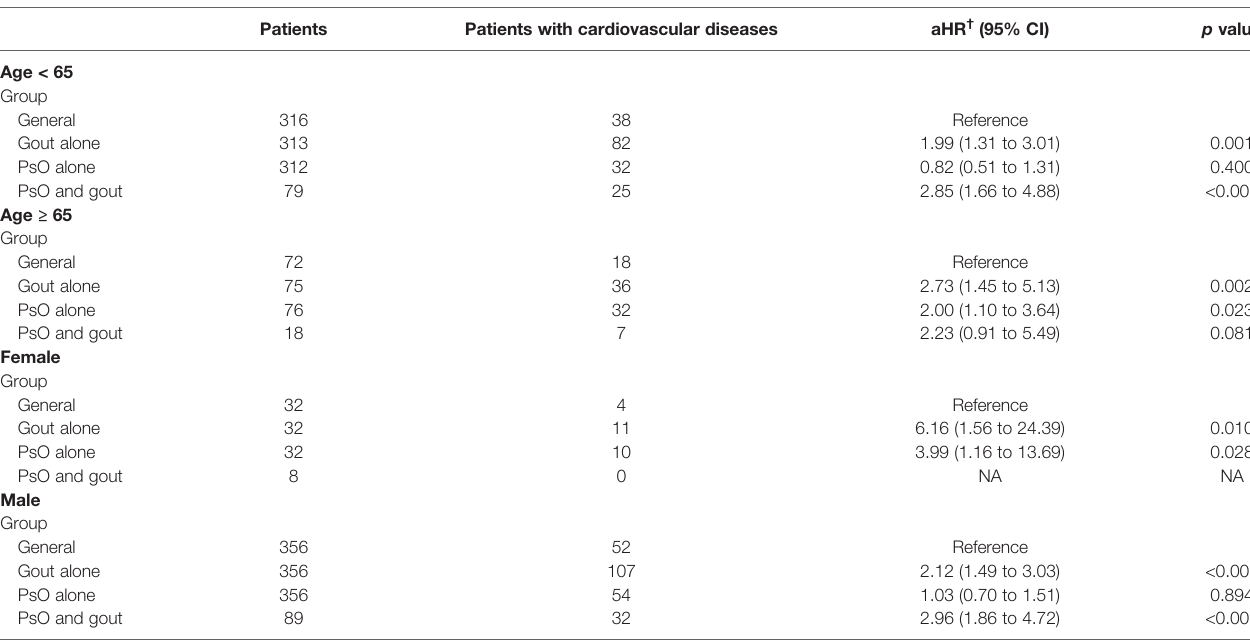
TABLE 4 | Subgroup analysis of risk for cardiovascular diseases.